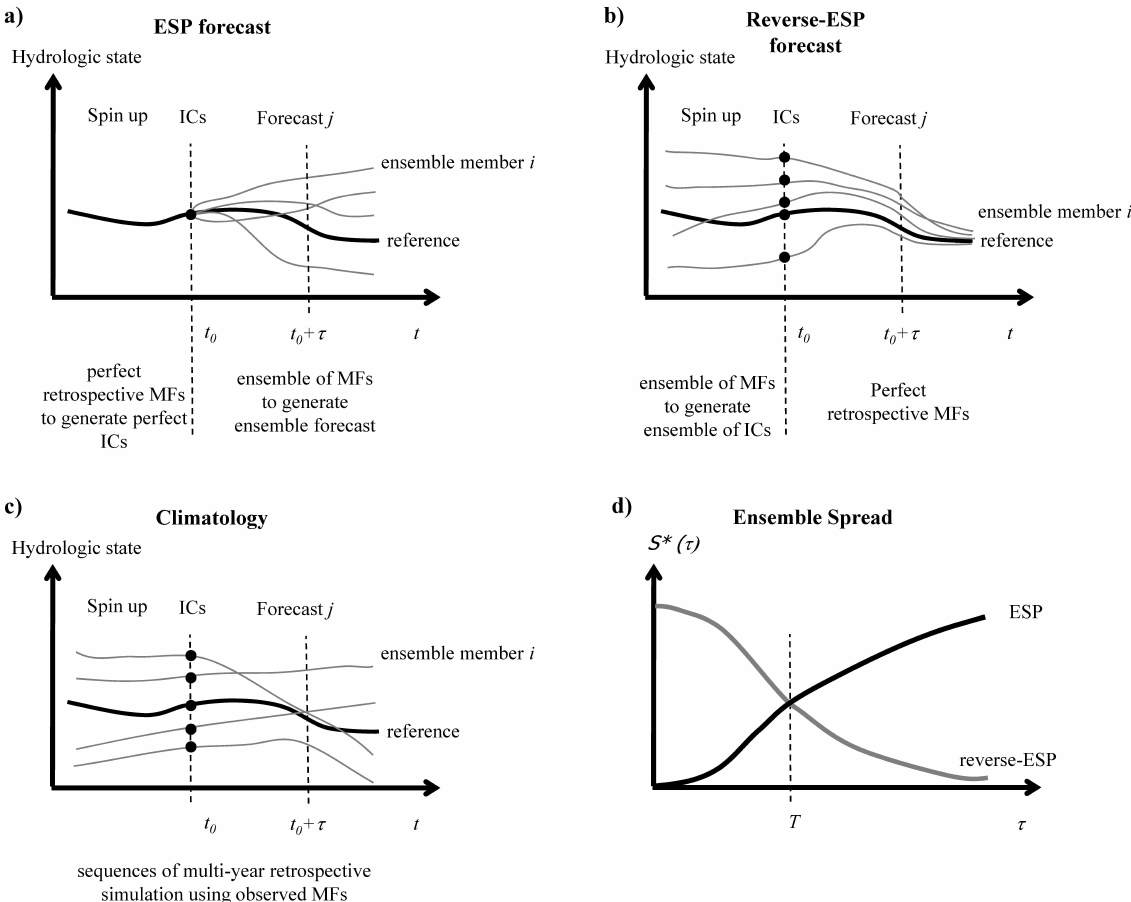
Fig. 2. Schematic representation of evolution of hydrologic states in spin-up and forecast for (a) ESP approach, (b) reverse-ESP approach, (c) climatology and (d) relative ensemble spread S * as function of lead time τ . Modified from Wood and Lettenmaier (2008).